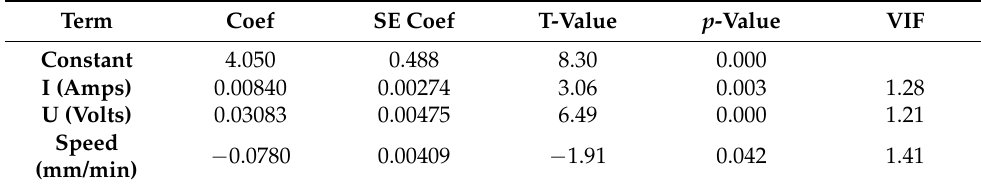
Table 2. ANOVA analysis of parameter’s effect on bead width.